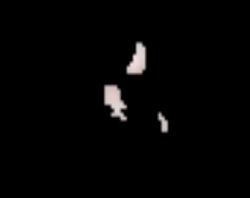
Figure 4. Targeted object with HSV.